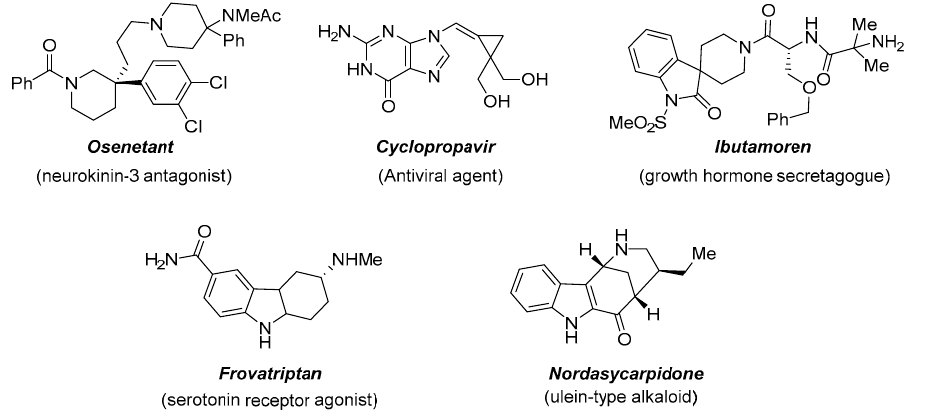
Figure 5. Biologically active substances featuring a quaternary stereocenter.